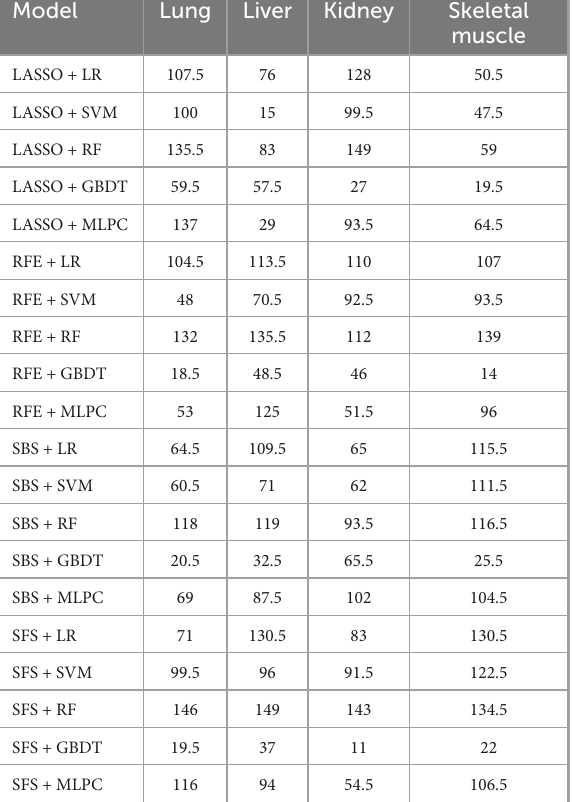
TABLE 2 The scores of sub-models generated by cross-combination of four feature selection methods and five machine learning